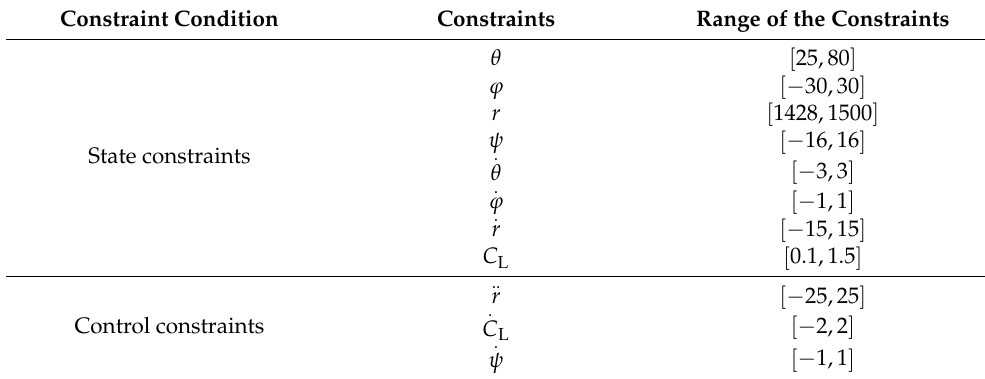
Table 3. Constraints of the states and controls in the trajectory tracking by